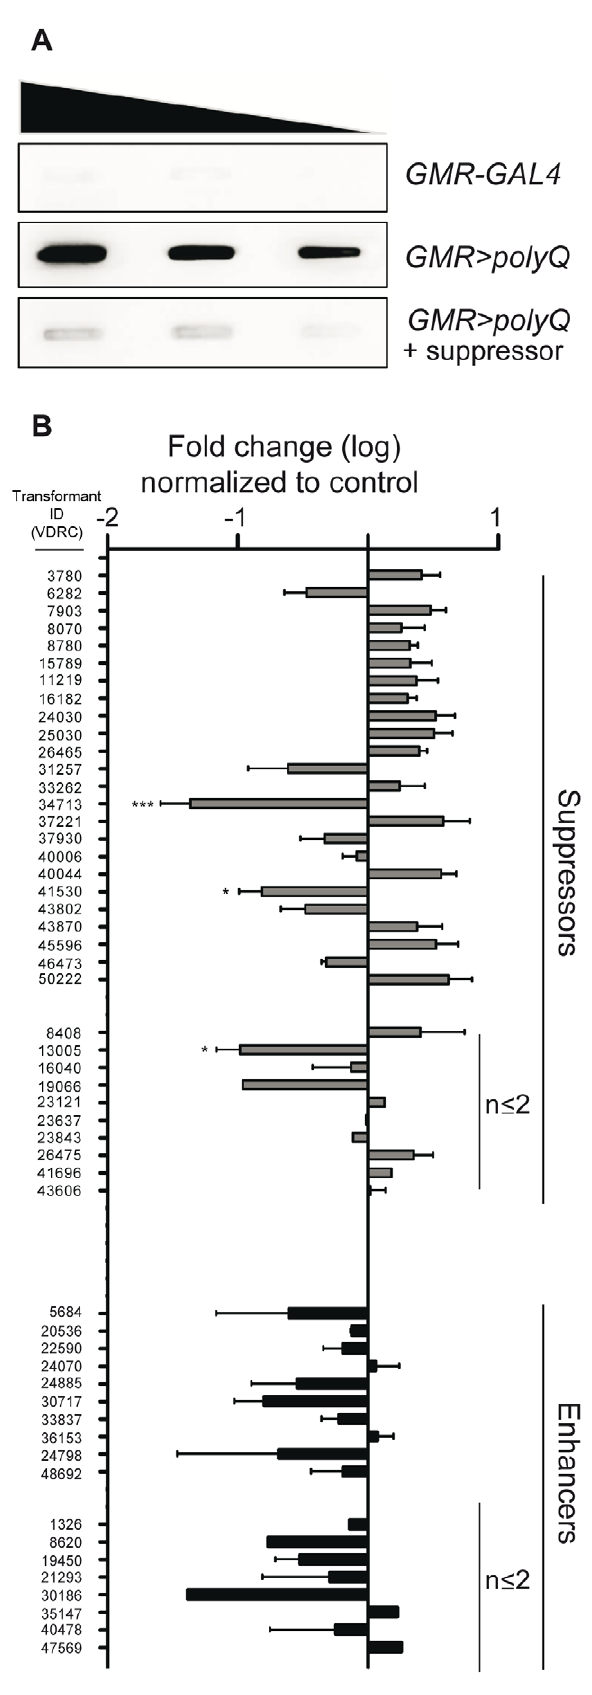
Figure 2. Analysis of polyQ aggregate load. ( A ) Exemplified filter retardation analysis to visualize polyQ aggregates. Decreasing amounts of loaded protein derived from fly heads of control ( GMR-GAL4 , top), GMR . polyQ (middle) or GMR . polyQ in combination with a candidate suppressor (bottom). ( B ) Densitometric measures of filter retardation analysis. Data depicted as fold change compared to control ( GMR . po- lyQ ) for suppressors and enhancers of polyQ-induced toxicity. Independent homogenates (if available) were used for repetitions. In case of none or only one independent repetition n # 2 is indicated. In all other cases, number of independent repetitions is n $ 3. Significant changes are indicated * p , 0.05; *** p ,